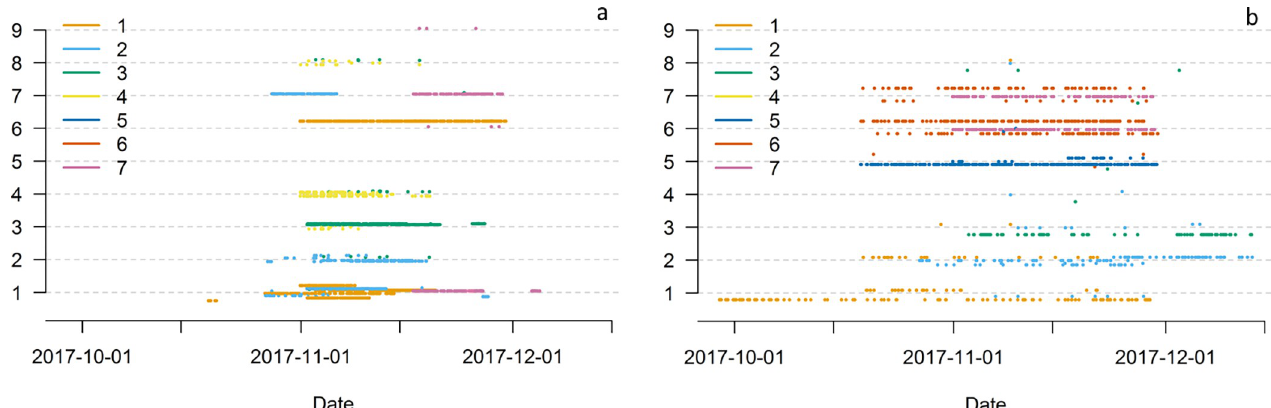
Fig 6. Time stream of juvenile (a) and adult (b) encounters with each base station, represented by warren number (vertical axis). Encounters are colour coded according to warren of capture (n = 7). Each line represents one logger, and vertical positioning of the logger indicates the base station number (warren number, n = 9) of detection. Overlapping data points are scattered for clarity. Only warren 5 had two functioning base stations, and data from both were merged.